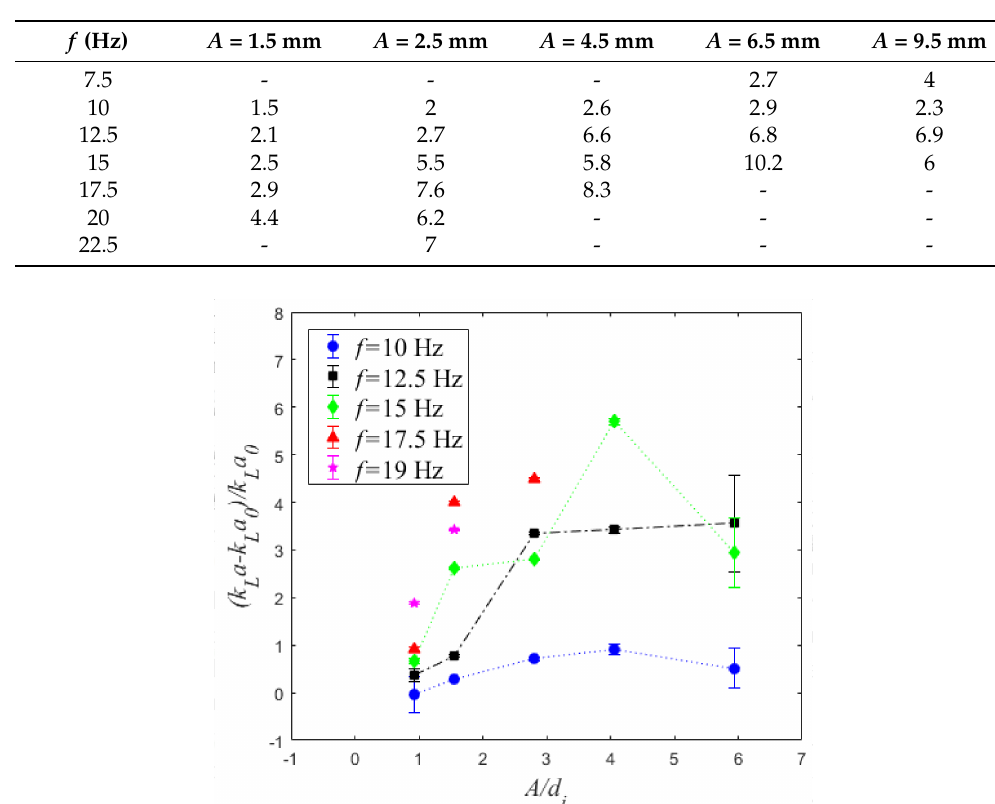
Table 1. Normalized volumetric mass transfer k L a / k L a 0 ( U SG = 5.0 mm/s).